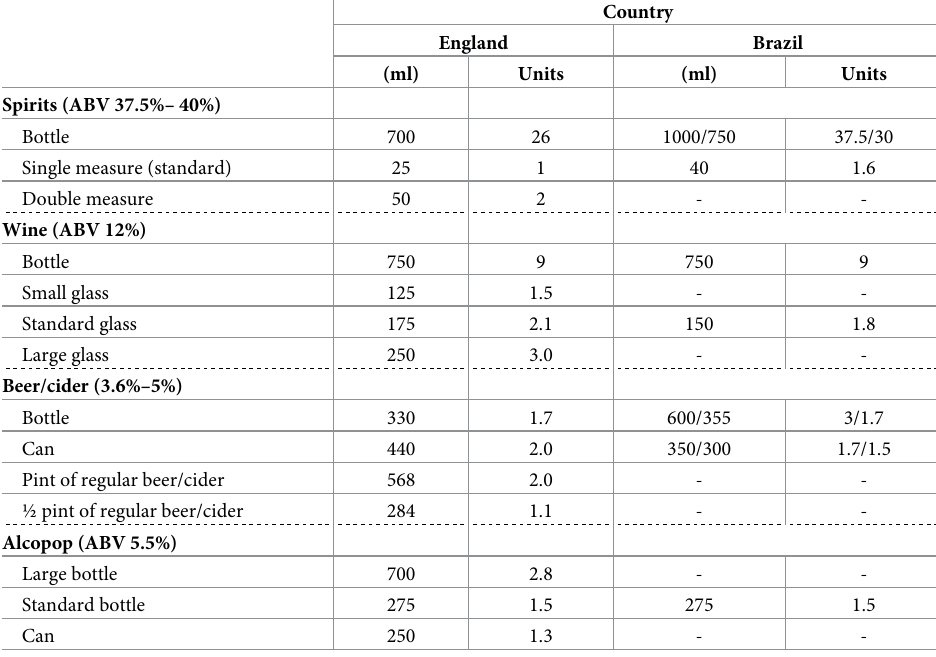
Table 1. Brazil and British drinks measures included in the